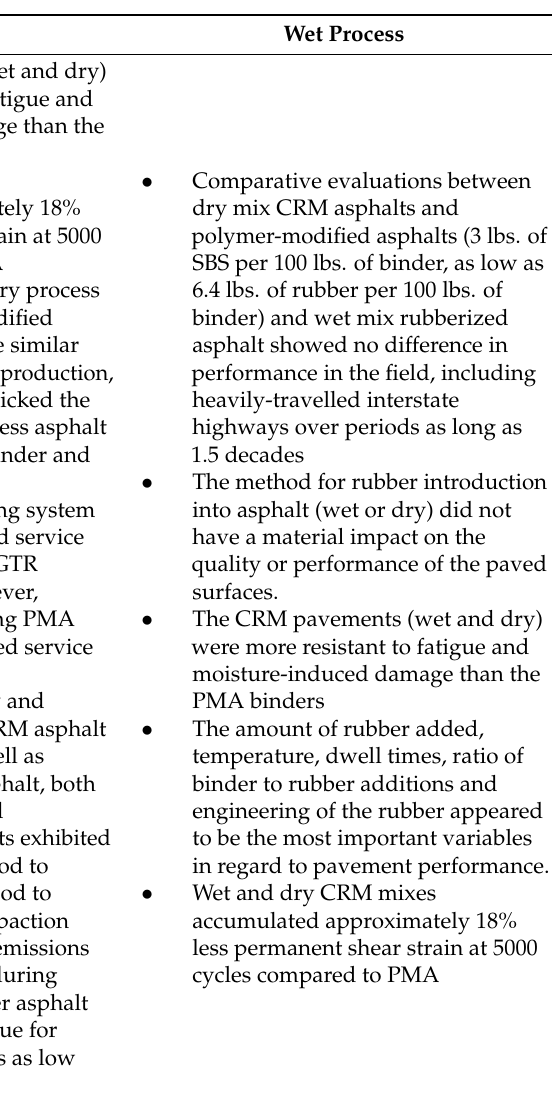
Table 5. Comparison of field performance aspects of dry and wet